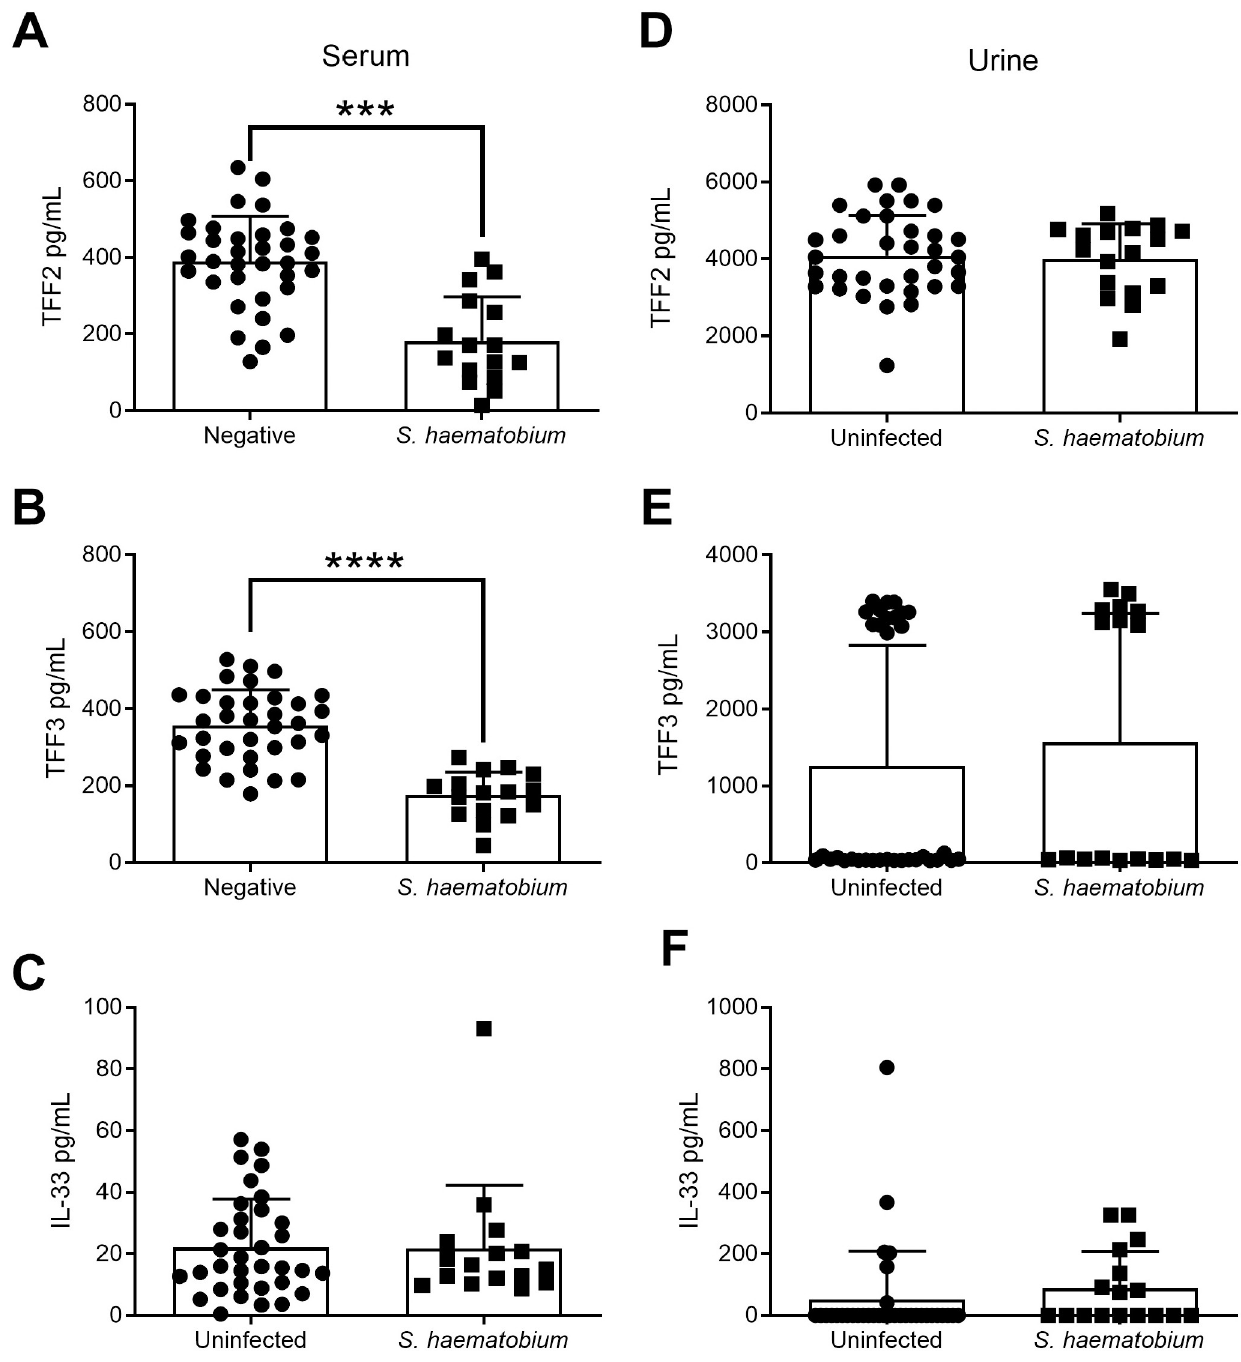
Fig 4. TFFs are decreased in serum but not urine samples from Nigerian children infected with S . haematobium . (A, B) Levels of TFF2 or (C, D) TFF3 in serum (A, C) and urine (B, D) samples from Nigerian school children infected with S . haematobium (n = 16–17) versus uninfected controls (n = 34). ��� p < 0.005, ���� p <